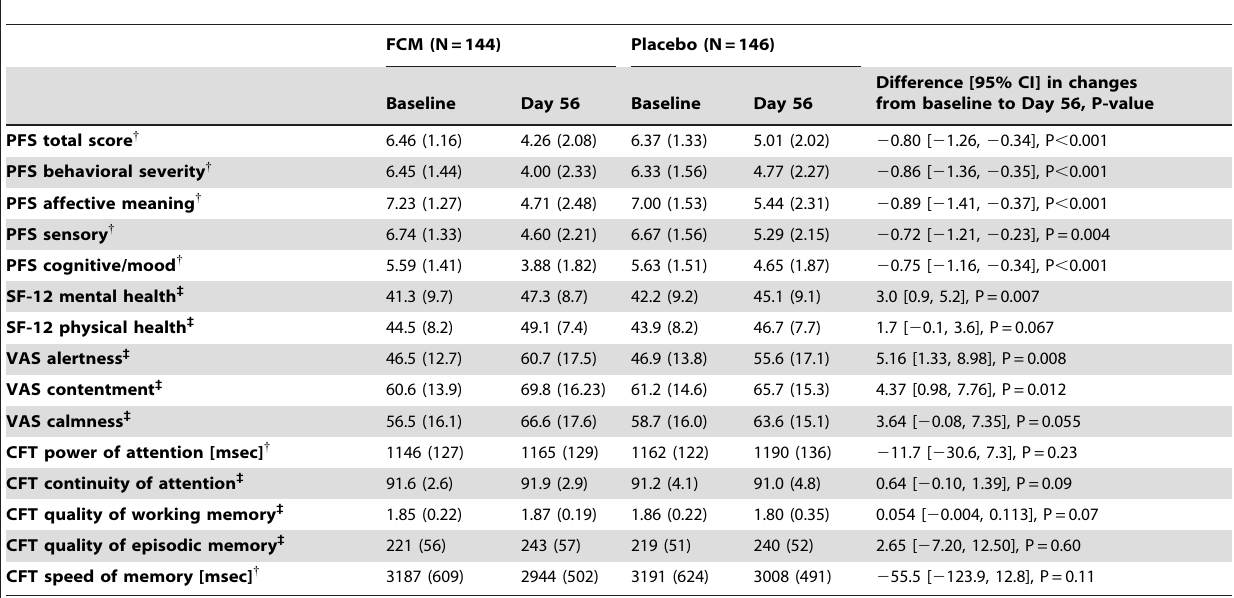
Table 3. Secondary endpoints – Fatigue, QoL and cognitive function tests (mean [SD]) (ITT).